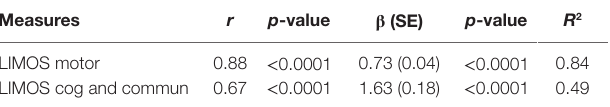
TaBle 3 | Measures of external responsiveness (correlation method and linear regression analysis) for the liMOs motor and liMOs cognition and communication with FiM motor and